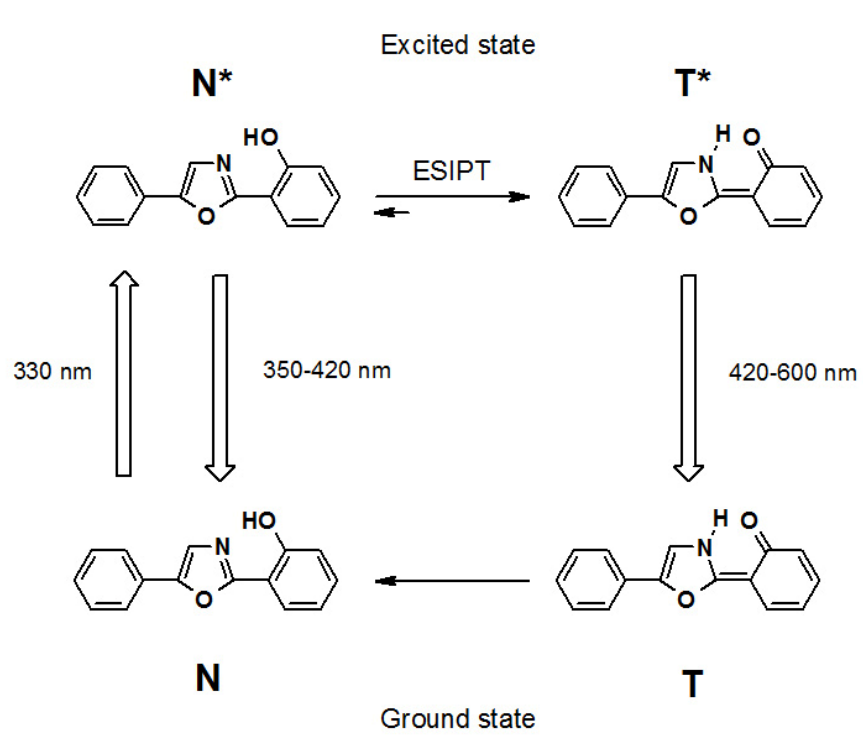
Figure 7. Scheme of excited state intramolecular proton transfer (ESIPT) reaction in 2 (2 ′ -hydroxyphenyl)-5-phenyl-1,3-oxazole (probe O1O). The upwards arrow denotes the electronic excitation and the downwards arrow designates the emission of light (fluorescence). Corresponding maximum absorption and the ranges of emission are shown in nanometers. (Modified from Posokhov and Kyrychenko, 2018).